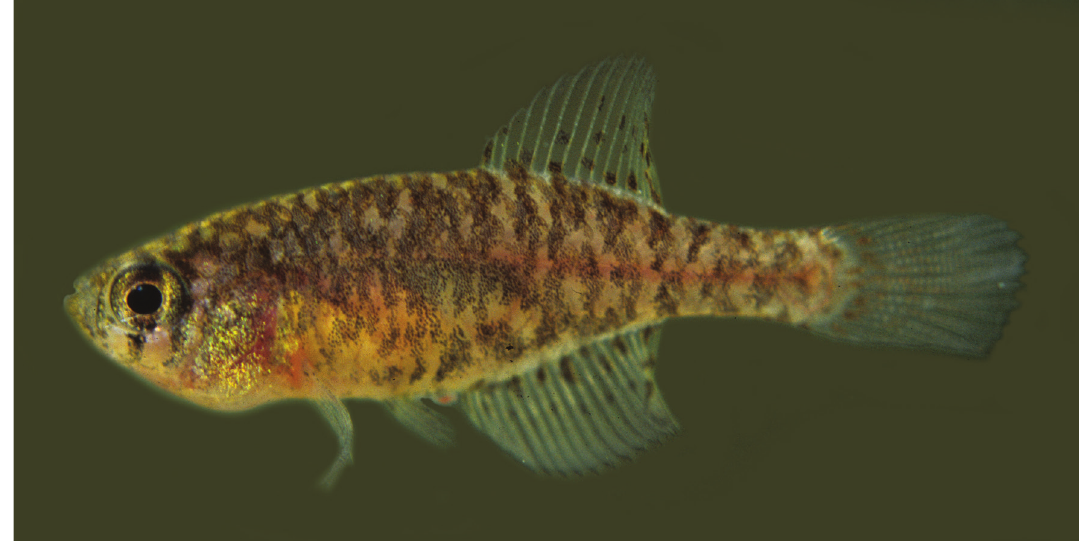
Figure 5. Spectrolebias gracilis sp. n., UFRJ 6441, paratype, female, 17.8 mm SL; Canabrava